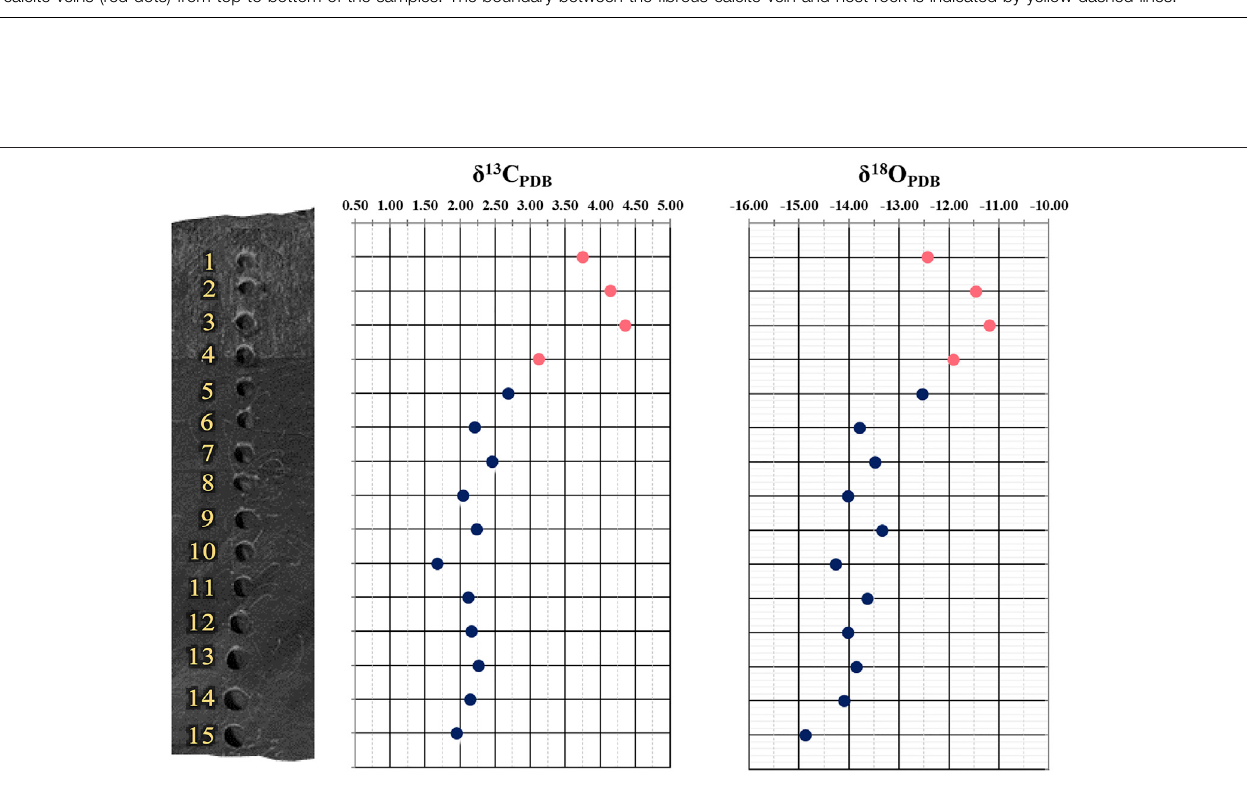
FIGURE 10 | The transection diagram of the Nam Duk sample (ND-1) shows δ 13 C PDB and δ 18 O PDB isotopic composition of host rock (black dots) and fi brous calcite veins (red dots) from top to bottom of the samples. The boundary between the fi brous calcite vein and host rock is indicated by a yellow dashed line.